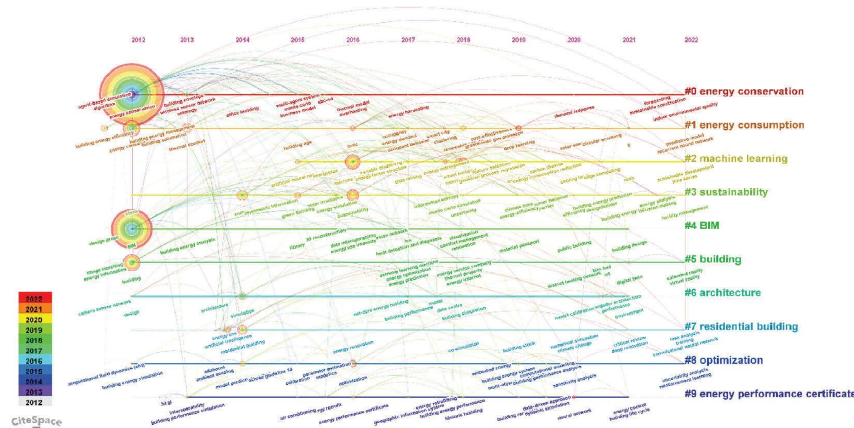
Figure 8: Keywords timelines